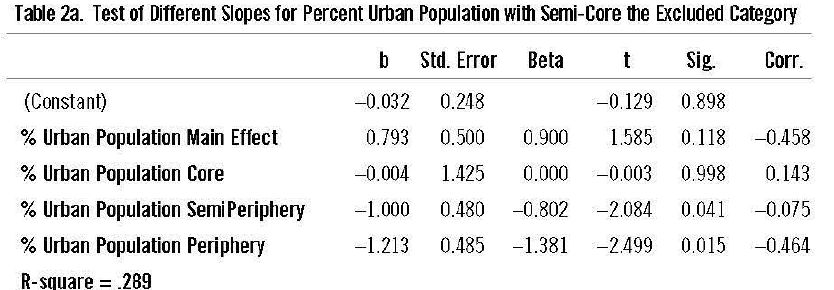
Table 2 - World-System Position by Urban Population Interactions Table 2a. Test of Different Slopes for Percent Urban Population with Semi-Core the Excluded Category